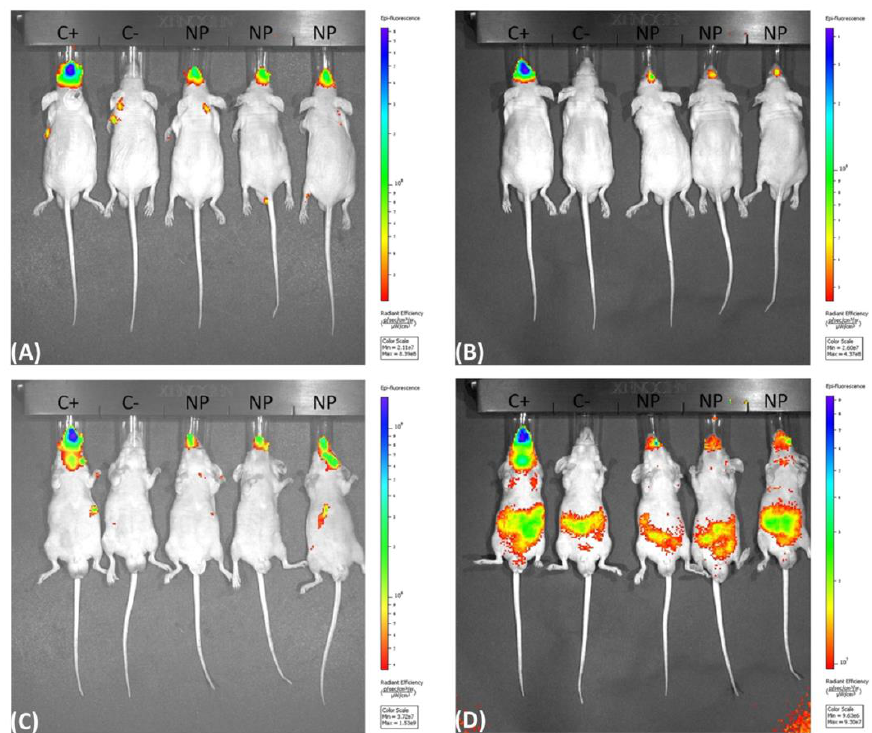
Figure 1. IVIS spectrum fluorescence obtained with the mice positioned in the prone (A and B) and supine (C and D) position, showing the fluorescence in the upper air way of the BABL/c nude mice